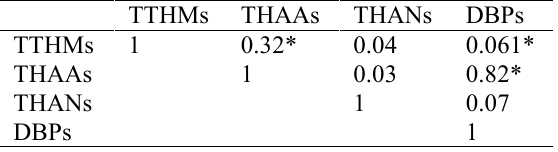
Table 3. The correlation coefficients for TTHMs, THAAs, THANs, and DBPs in the water samples from